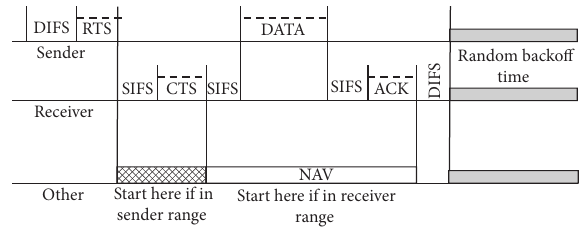
Figure 1: Medium access and data transmission in IEEE